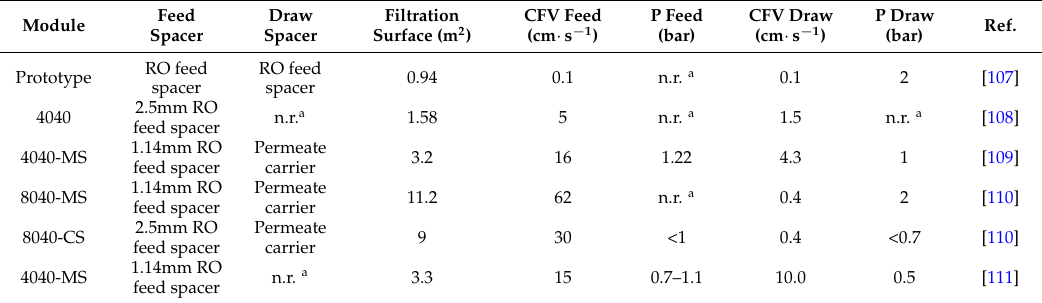
Reported module configurations and operating parameters for HTI modules (CFV: cross-flow